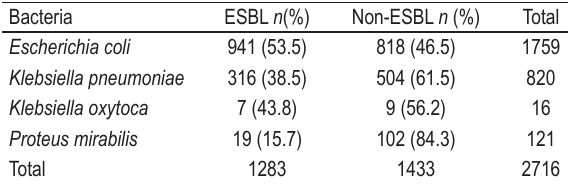
TABLE 4. ESBL production rate by Enterobacteriaceae strains